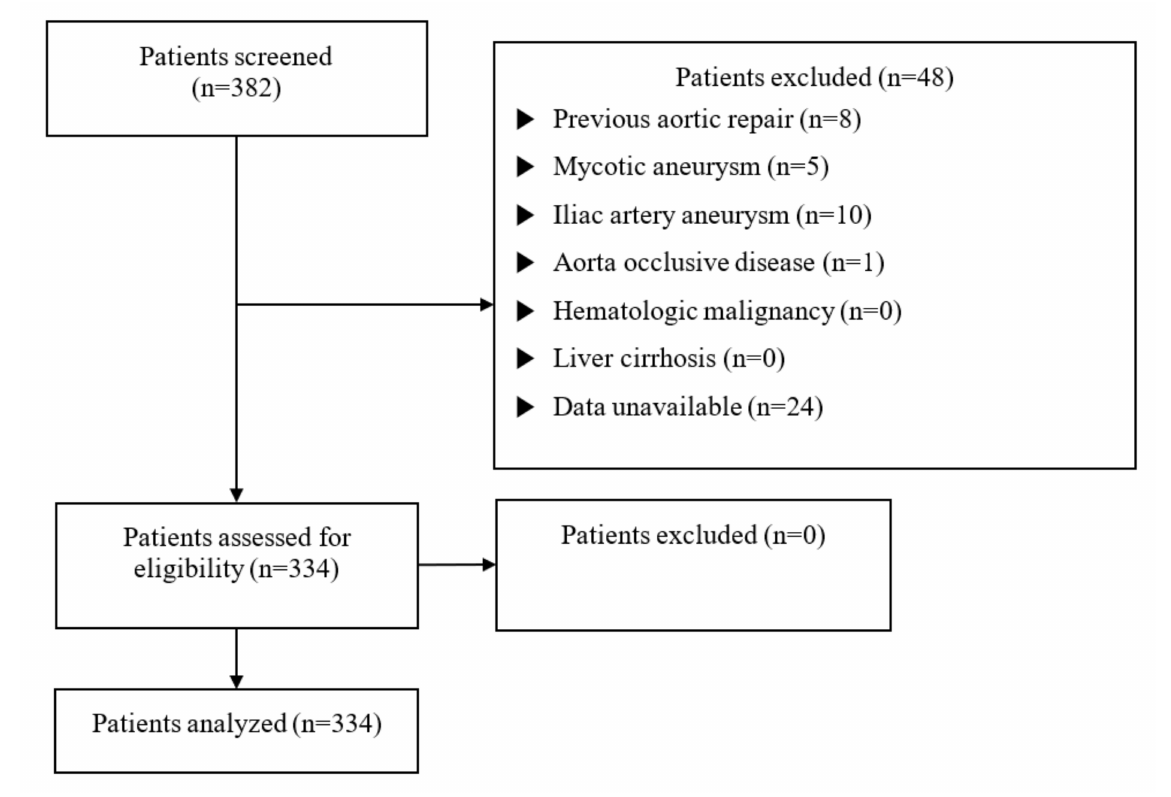
Figure 1. Flowchart depicting patient